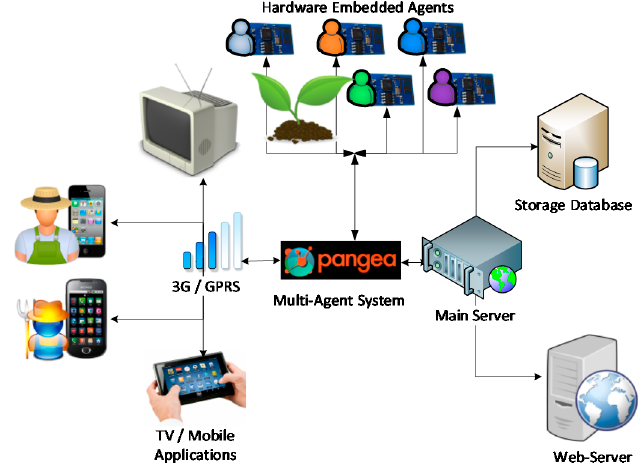
Figure 16. Scheme platform.